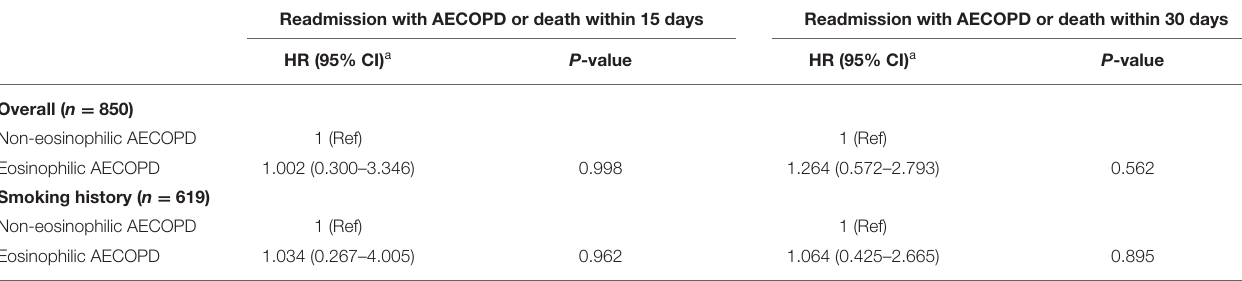
TABLE 2 | Readmission with AECOPD or death within 15 and 30 days in the matched